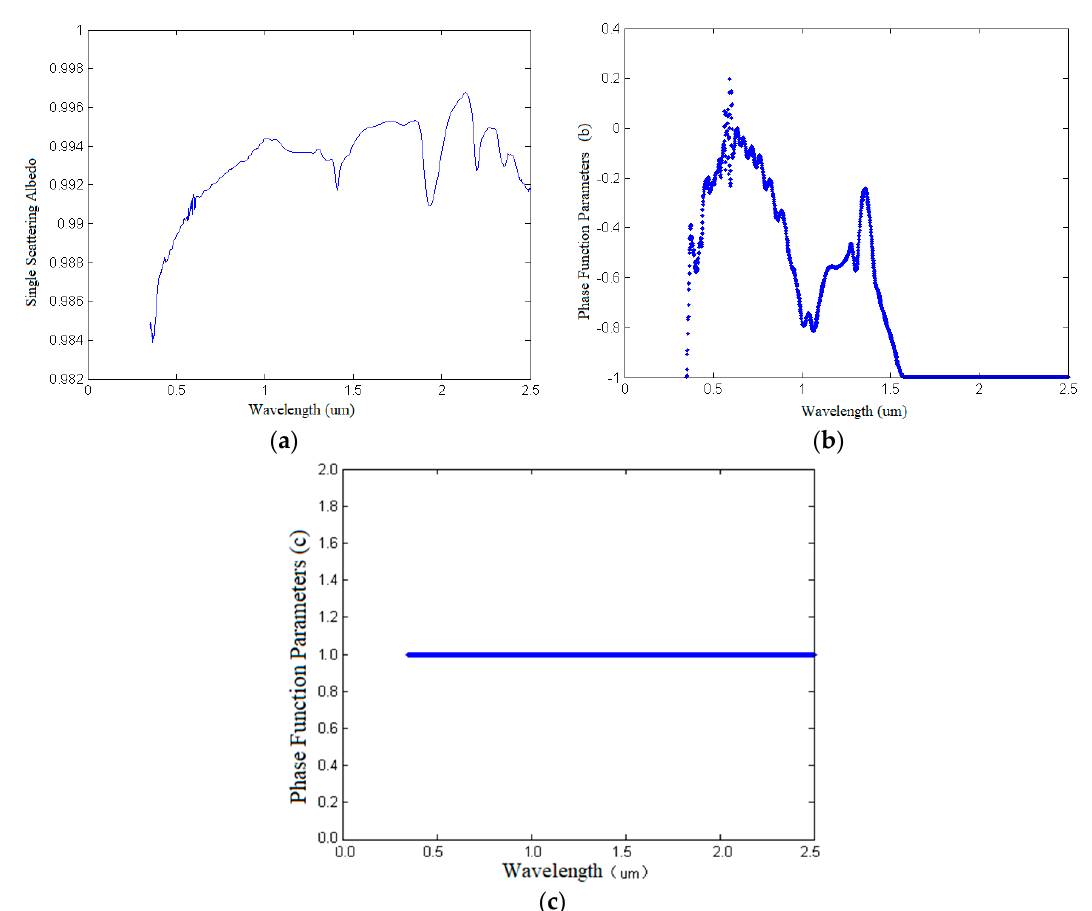
Figure 13. Photometric parameters of plagioclase: ( a ) SSA (w), ( b ) Legendre polynomial coefficient of the phase function b, and ( c ) Legendre polynomial coefficient of the phase function c of plagioclase.